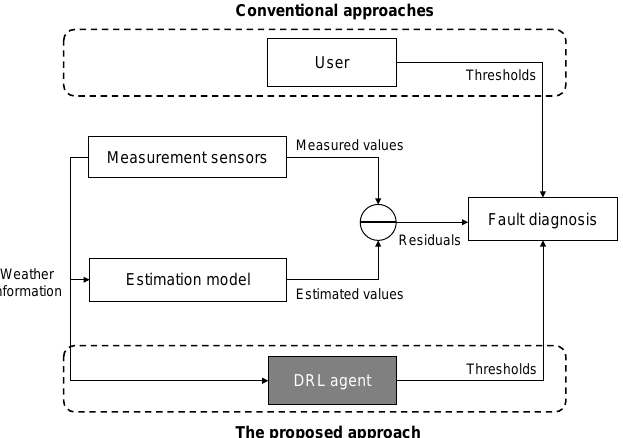
Figure 1. The proposed DRL-based threshold scheme for detecting the inverter faults of PV systems.